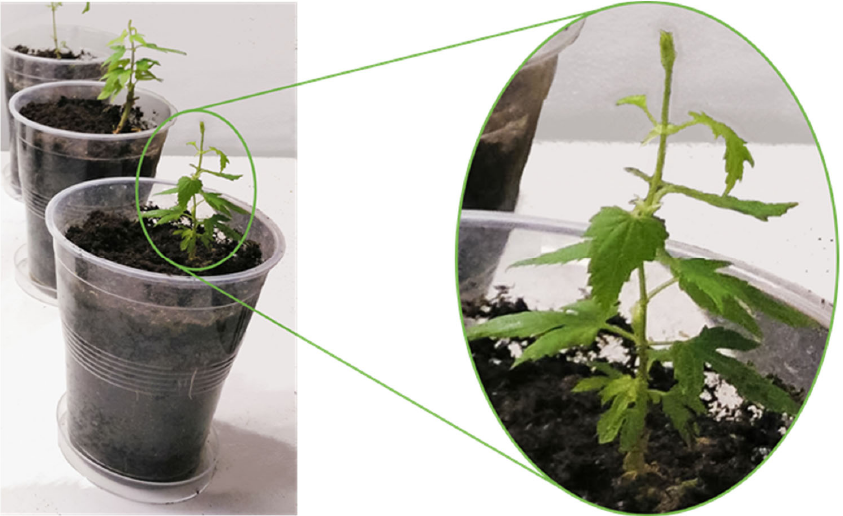
Figure 1. Hop plantlets with one string and five–six nodes per plant. Plantlets were inoculated with 5 mL of each Trichoderma spore solution (1 × 10 7